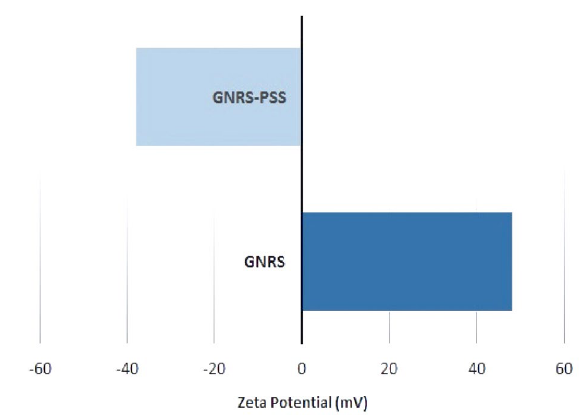
Figure 4. Analysis of zeta potential for pristine and PSS-coated